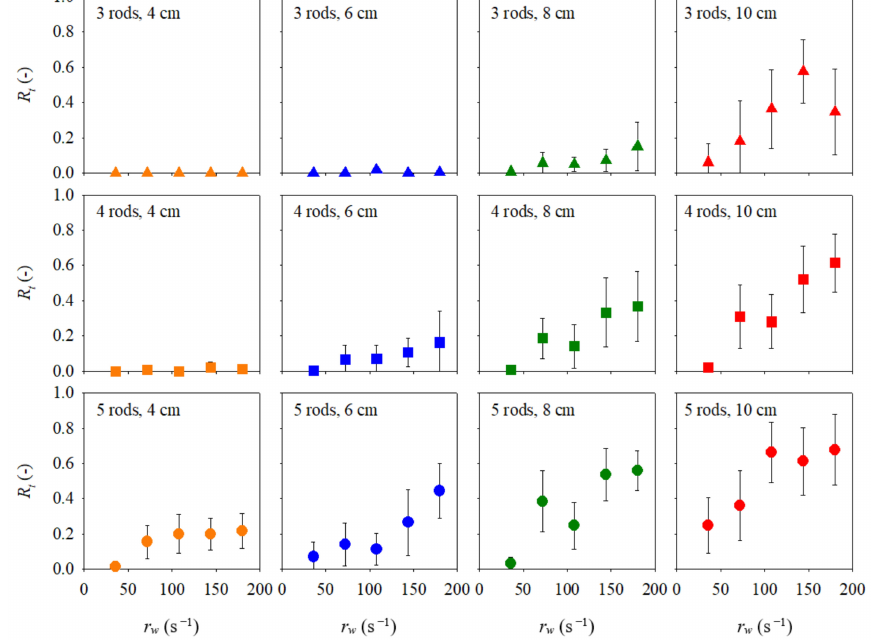
Figure 9. Experimental relationship between the LW supply rate ( r w ) and the trapping rate ( R t ) with the constant spacing LW supply method. The dots and bars are the means and standard deviations of the trapping rates (triangle: 3 rods, square: 4 rods, circle: 5 rods, orange: 4 cm, blue: 6 cm, green: 8 cm, red: 10 cm LW).